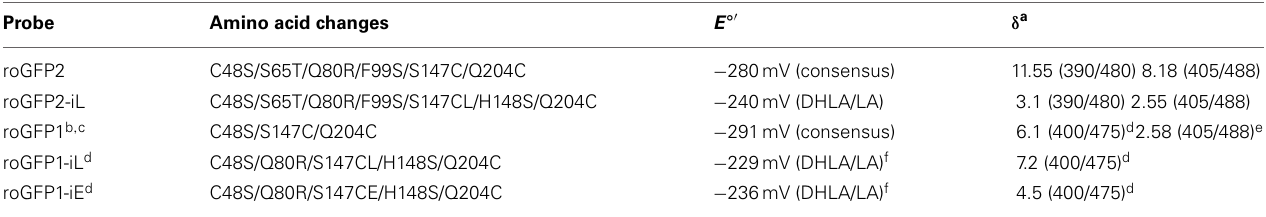
Table 1 | Mutations, redox potentials, and dynamic range of GFP derived redox